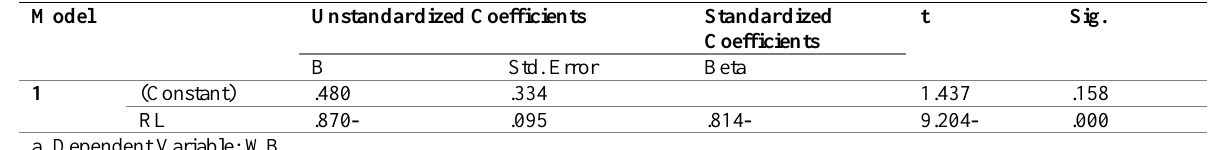
Table 11: Results of Linear Regression between Resonant Leadership and Workplace Bullying